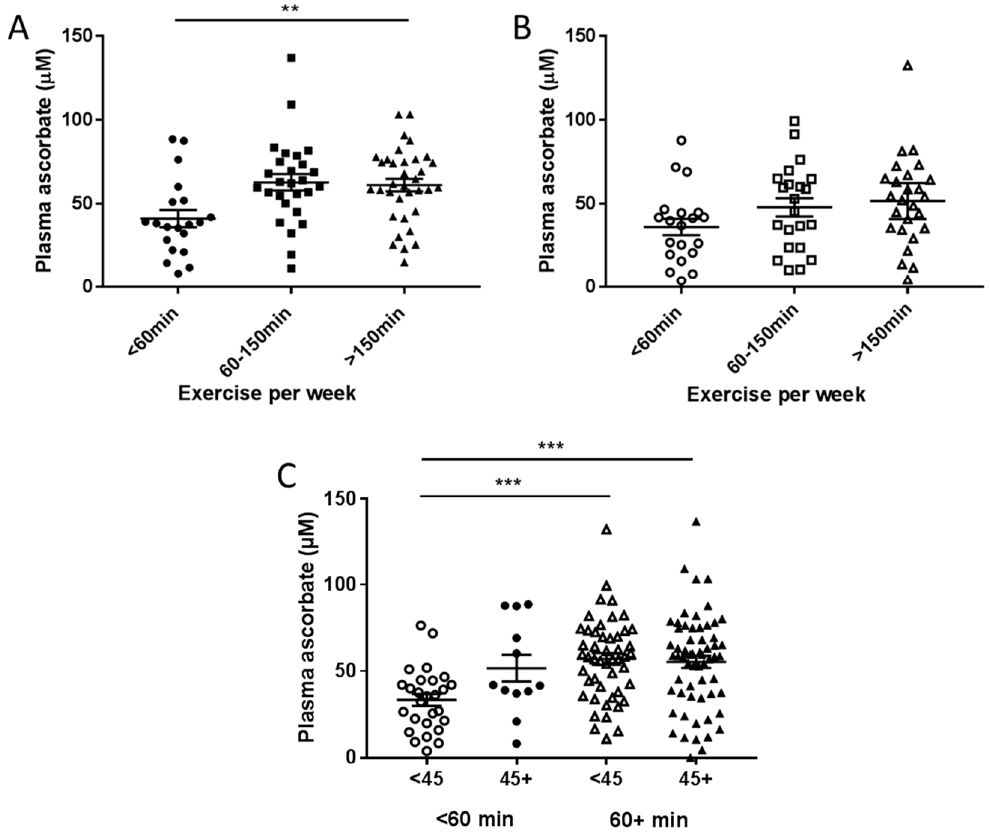
Figure 4. Fasting plasma ascorbate levels according to reported exercise levels in patients from the pre-surgical ( A ) and treatment cohorts ( B ). ( C ) Association of plasma ascorbate and exercise with intake dicotemized at NZ RDI of 45 mg / day and exercise dicotemized at 60 min / week. Pre-surgical cohort n = 81, therapy cohort n = 69. ** p = 0.004 one-way analysis of variance (ANOVA), *** p < 0.001 unpaired t -test, mean ± SEM.